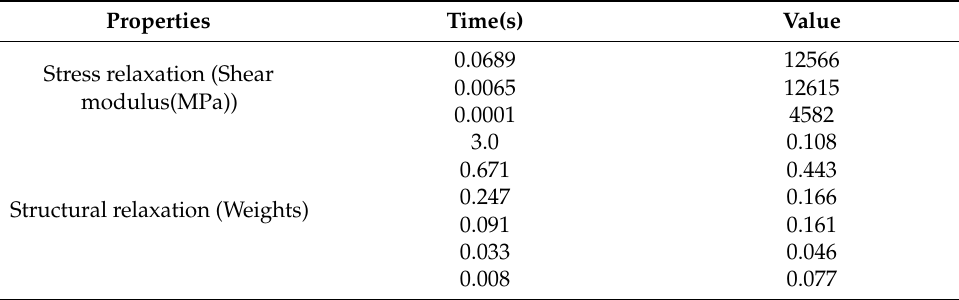
Table 2. Relaxation model parameters of G-11